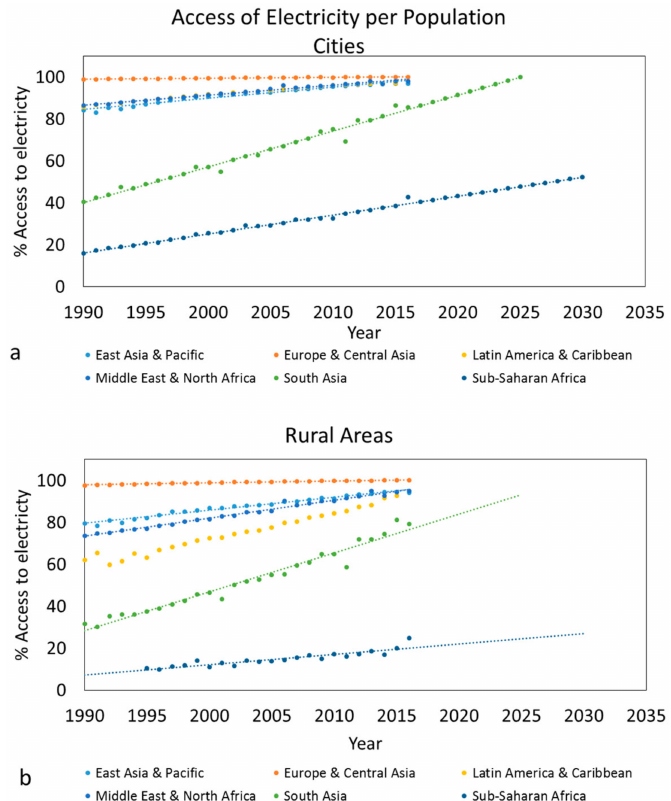
Figure 2. Percentage of population with electricity access during 1990 to 2016 with a projection to 2030 ( a ) cities and ( b ) rural areas. Data provided by the World Bank